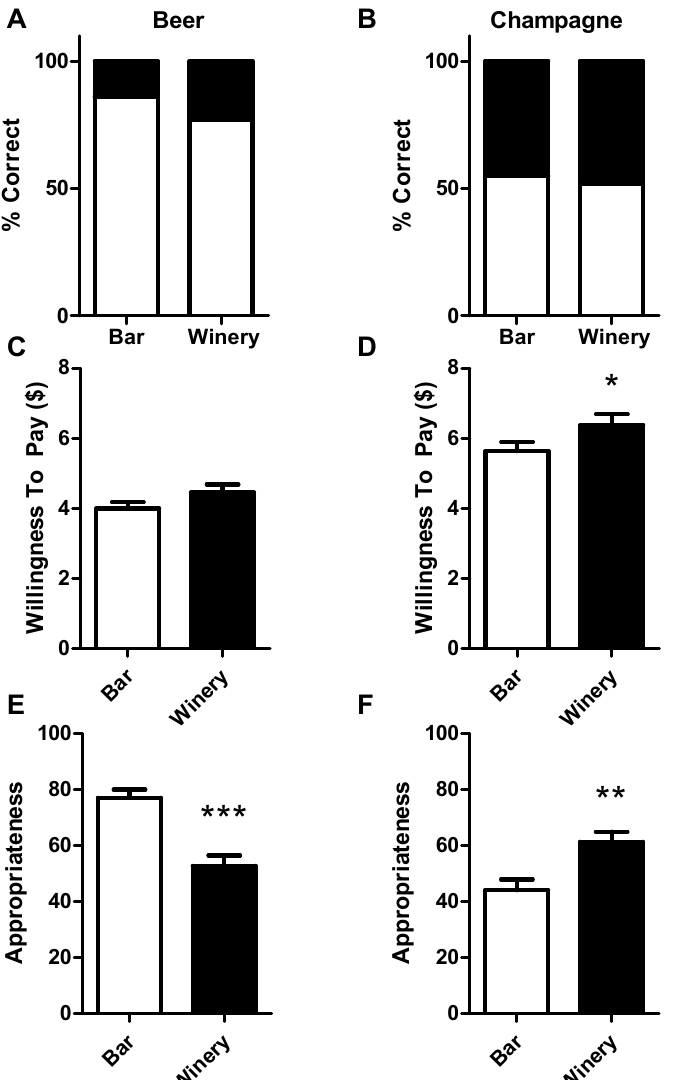
Figure 3. ( A ) Panelists’ identification of beer samples presented in the study (correct identifications in white, incorrect in black). ( B ) Panelists identified the champagne sample approximately as well in both the bar and winery contexts. ( C ) Panelists showed no difference in the amount they were willing to pay for beer in either context; bars denote mean plus SEM. ( D ) Panelists were willing to pay almost a dollar more for the champagne sample while in the winery than the bar context; bars denote mean plus SEM. ( E ) Beer appropriateness for context, from “not appropriate at all” (0) to “very appropriate” (100); bars denote mean plus SEM. ( F ) Champagne appropriateness for context; axis as E; bars denote mean plus SEM. Asterisks denote: * p < 0.05; ** p < 0.01; *** p < 0.001.